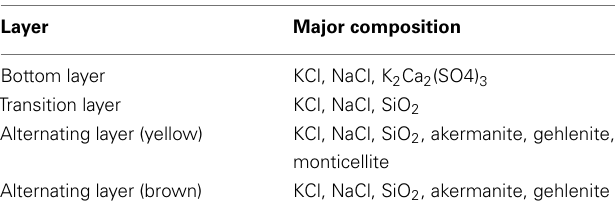
Table 2 | Slag composition in the intermediate-temperature